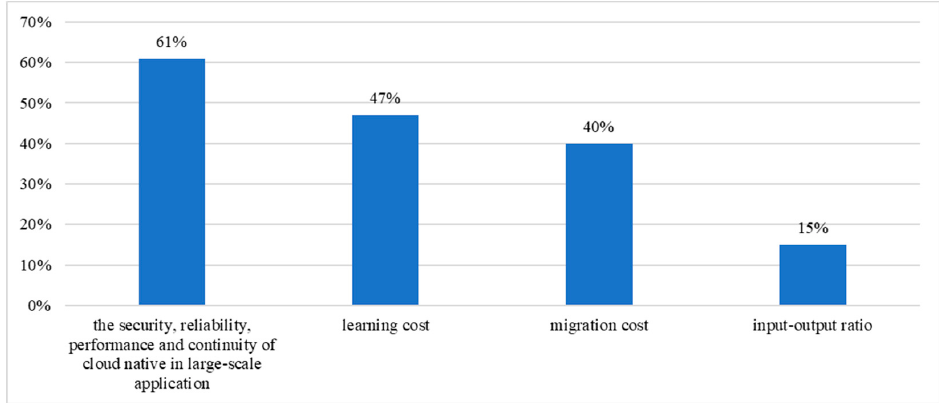
Figure 1. Users’ concerns about using cloud-native.